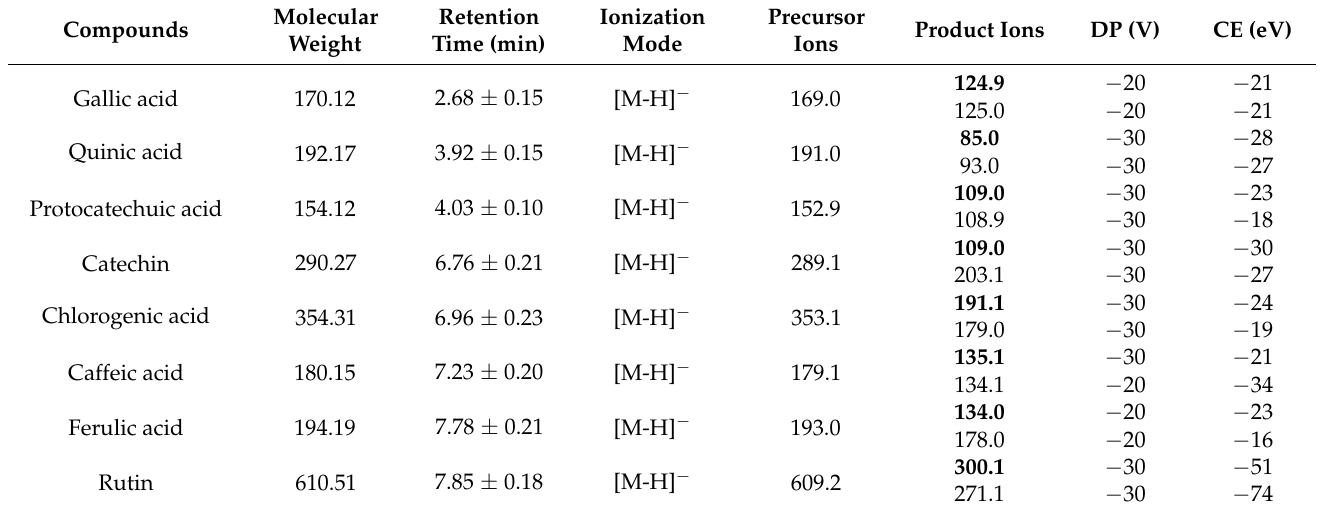
Table 1. The optimized parameters of multiple reaction monitoring (MRM) mode ( n = 6)